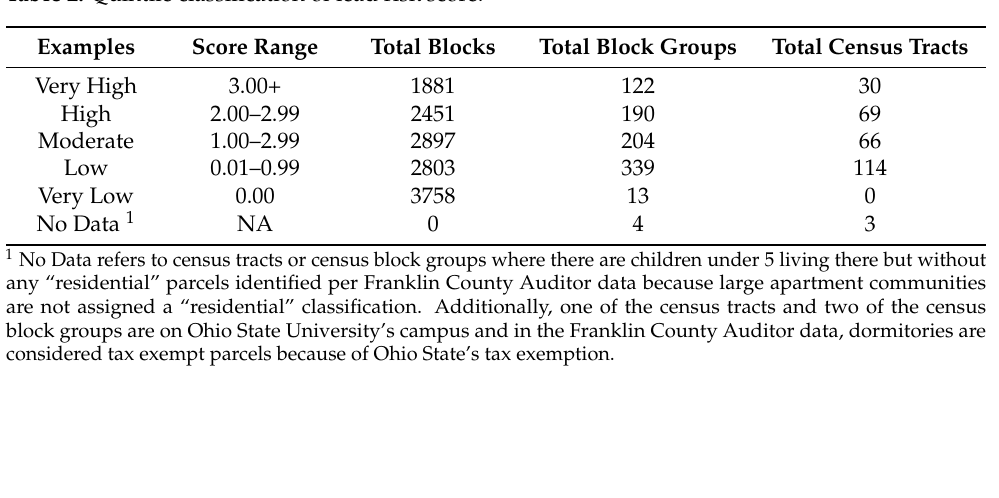
Table 2. Quintile classification of lead risk